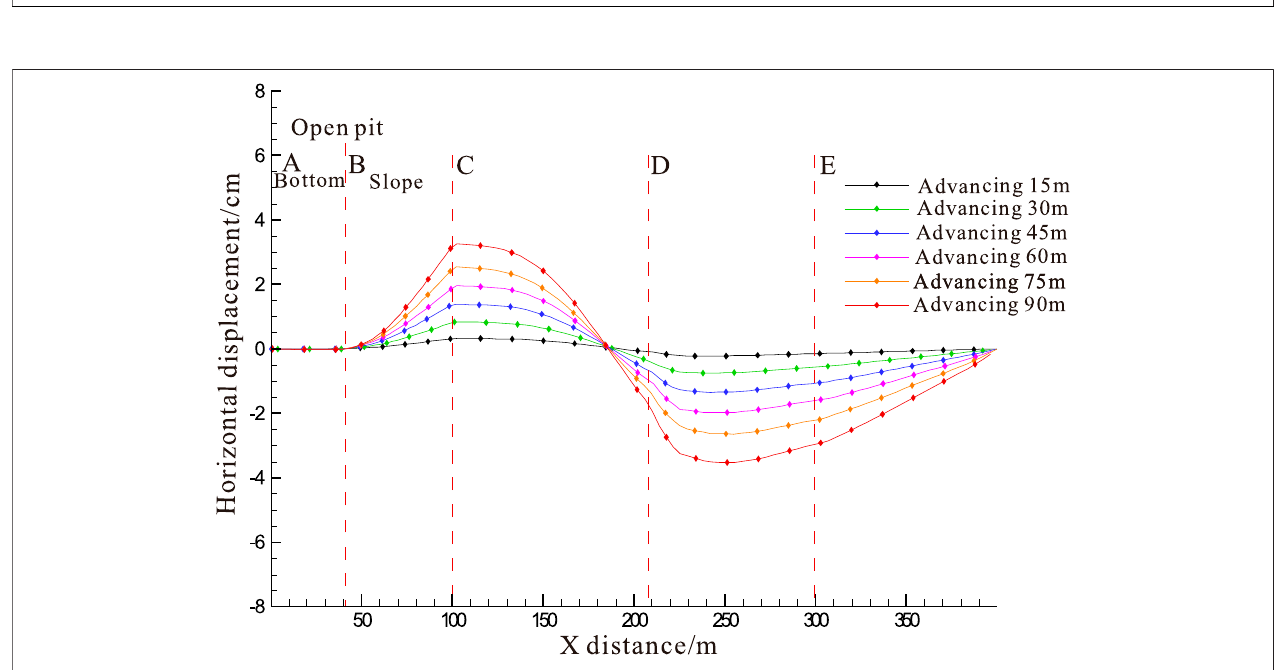
FIGURE 18 | Horizontal displacement curves of the surface at different advance